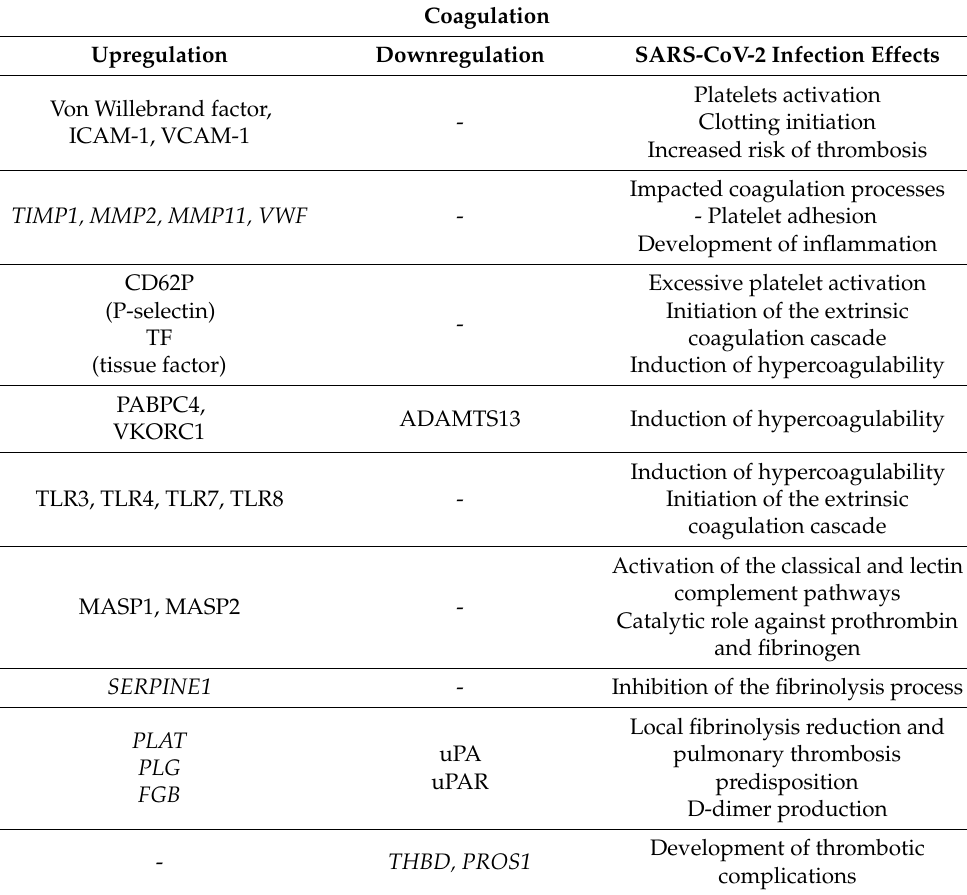
Table 2. Processes connected to coagulation in the lungs of COVID-19